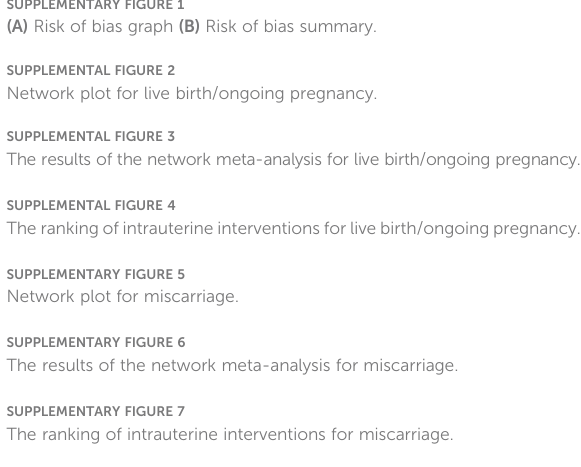
SUPPLEMENTARY FIGURE 1 (A) Risk of bias graph (B) Risk of bias summary. SUPPLEMENTAL FIGURE 2 Network plot for live birth/ongoing pregnancy. SUPPLEMENTAL FIGURE 3 The results of the network meta-analysis for live birth/ongoing pregnancy. SUPPLEMENTAL FIGURE 4 The ranking of intrauterine interventions for live birth/ongoing pregnancy. SUPPLEMENTARY FIGURE 5 Network plot for miscarriage. SUPPLEMENTARY FIGURE 6 The results of the network meta-analysis for miscarriage. SUPPLEMENTARY FIGURE 7 The ranking of intrauterine interventions for miscarriage. SUPPLEMENTARY TABLE 1 Characteristics of the included